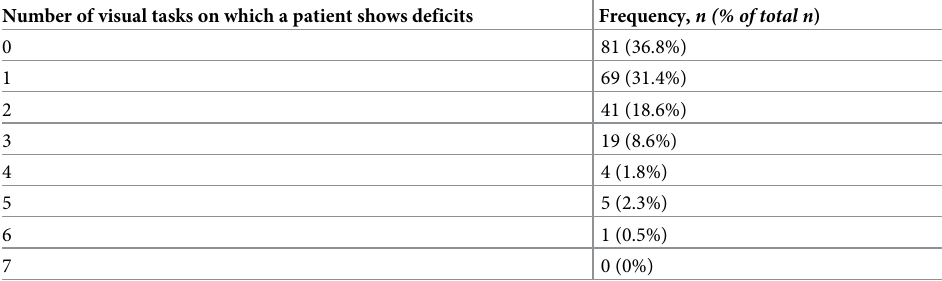
Table 5. Frequency-table: On how many tasks do patients show deficits? Number of visual tasks on which a patient shows